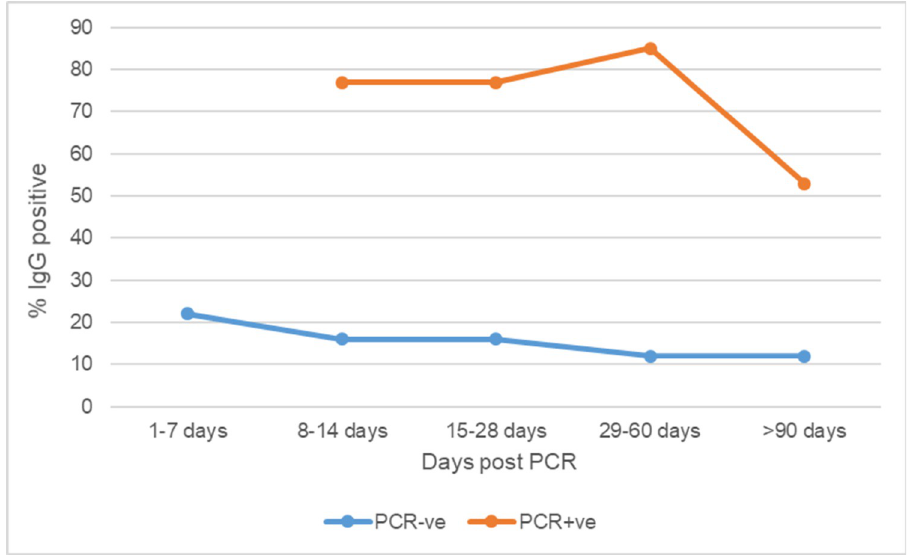
Fig 1. Proportion of HCWs and nonclinical staff with positive IgG antibody over time after PCR